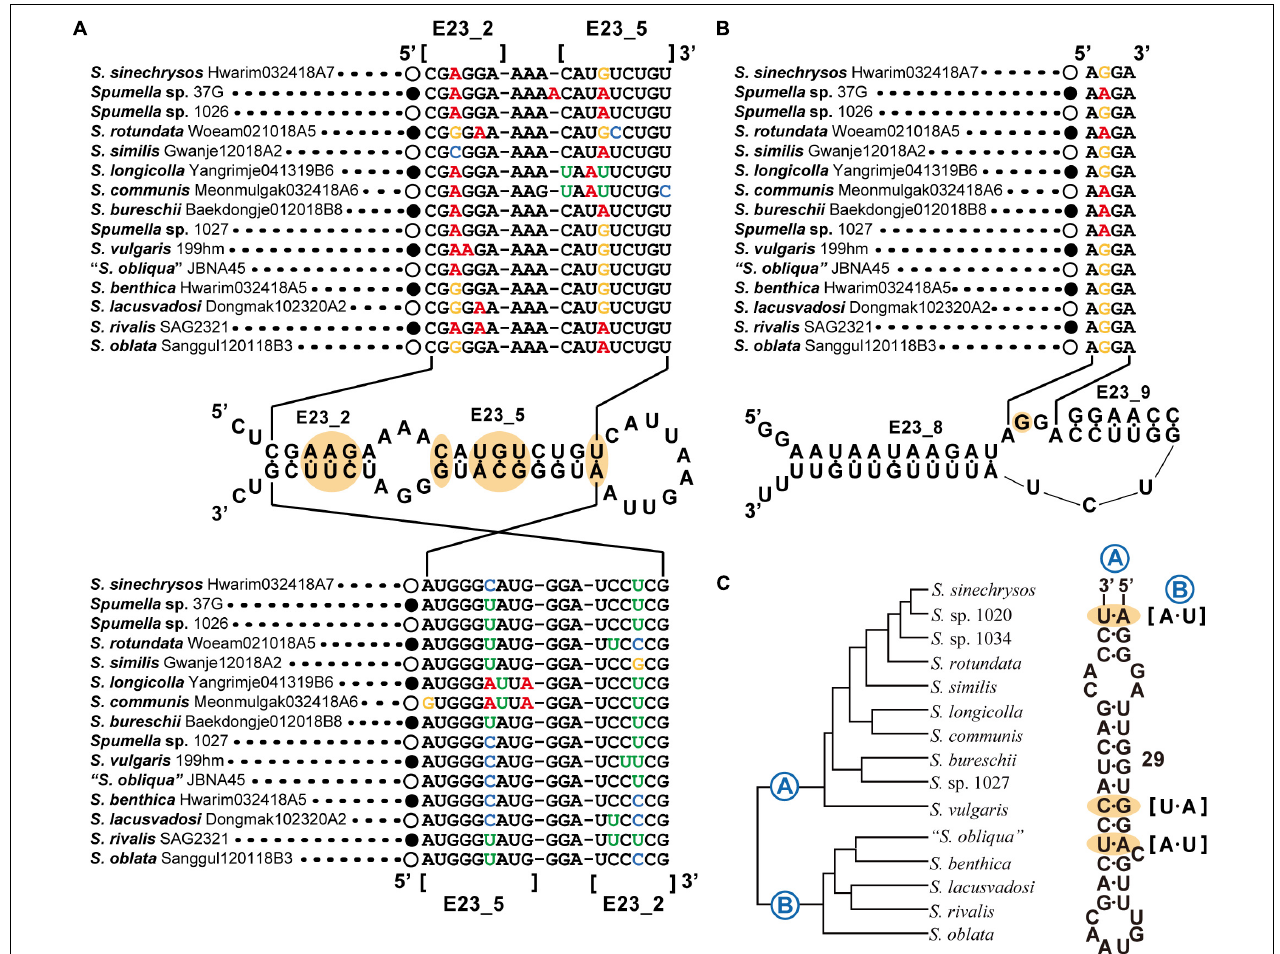
FIGURE 3 | Molecular signatures of Spumella species using secondary structures from E23_2 to E23_5 (A) , E23_8 to E23_9 of the V4 region (B) and domain 29 of the V5 region (C) in the nuclear SSU rRNA gene sequence. The secondary structure was constructed based on S. vulgaris . The nomenclature of nucleotides depends on the polarity of the DNA: increasing numbers generally indicate the 5 (cid:48) –3 (cid:48) direction. [] indicates the beginning and end of the stem